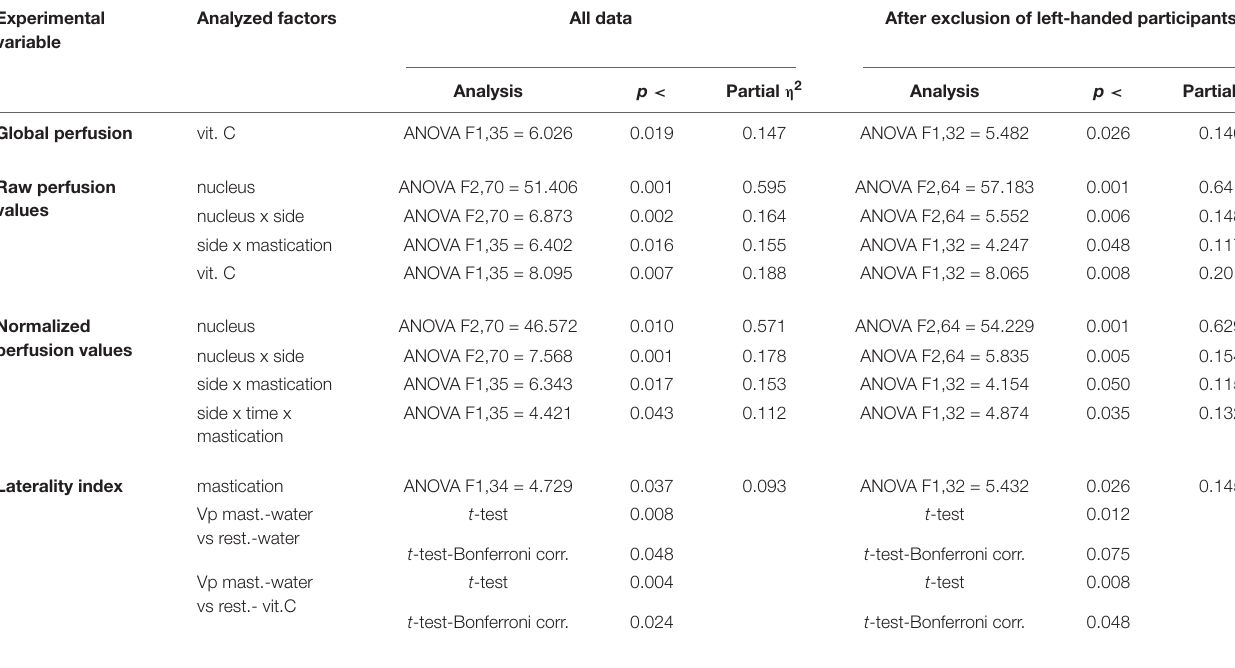
TABLE 3 | Results of the statistical analysis with or without exclusion of left-handed participants. Experimental